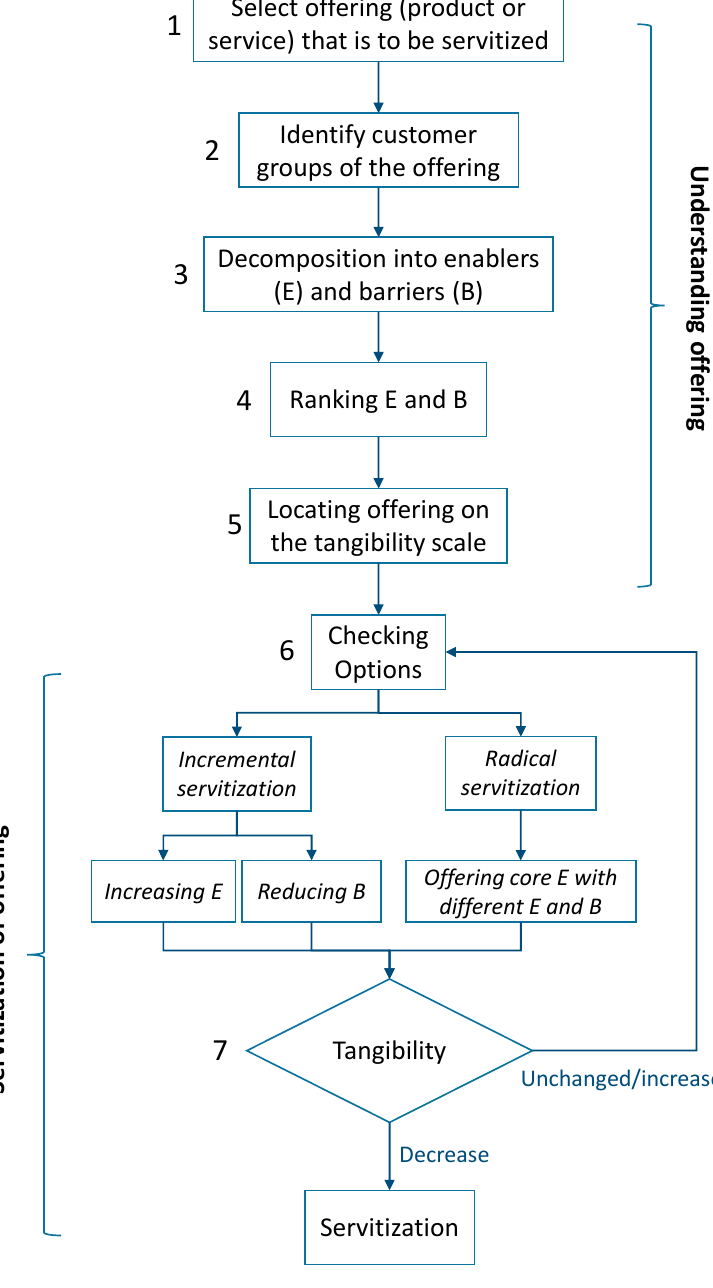
Figure 2. Servitization model.